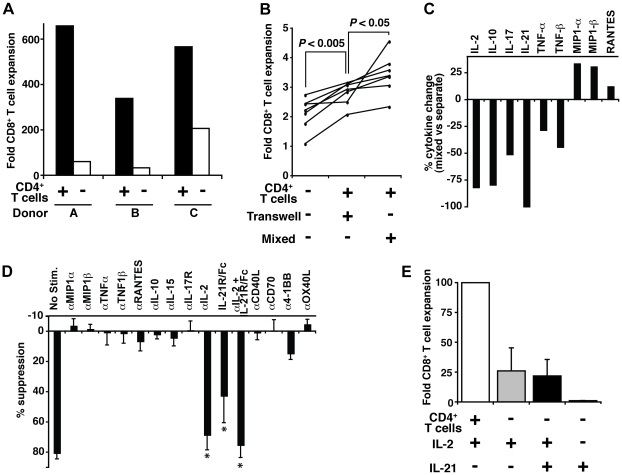
Autologous CD4+ T cell secretion of IL-2/IL-21 is necessary but not sufficient to help CD8+ T cells proliferate.(A) CD8+ T cells were stimulated twice by aAPC/mOKT3 with or without CD4+ T cells and treated with IL-2 between stimulations. Fold expansion of CD8+ T cells over 28 days is shown for 3 donors. (B) CD8+ T cells were stimulated only once by aAPC/mOKT3 with or without CD4+ T cells in transwell plates. No IL-2 or other cytokines were given. Fold expansion of CD8+ T cells over 6 days is shown for 7 donors. (C) Culture supernatants were tested for a panel of soluble factors to identify mediators of CD4+ T cell help. Relative changes in cytokines, comparing mixed vs. separate cultures, are shown. Data is representative of two donors. Absolute values for two donors are shown in Table S1. (D) Suppression of CD8+ T cell expansion in the presence of CD4+ T cells by blocking reagents is presented as percent suppression relative to control. Values indicate mean of four independent experiments; error bars show s.d. *P<0.005. (E) CD8+ T cells were stimulated twice with aAPC/mOKT3 in the presence or absence of CD4+ T cells. IL-2, IL-21, or both were added in each condition. Fold expansion of CD8+ T cells over 28 days is shown. Percent expansion was calculated by dividing the number of expanded CD8+ T cells by the number of CD8+ T cells expanded in the presence of CD4+ T cells. Values indicate mean of six independent experiments; error bars show s.d.